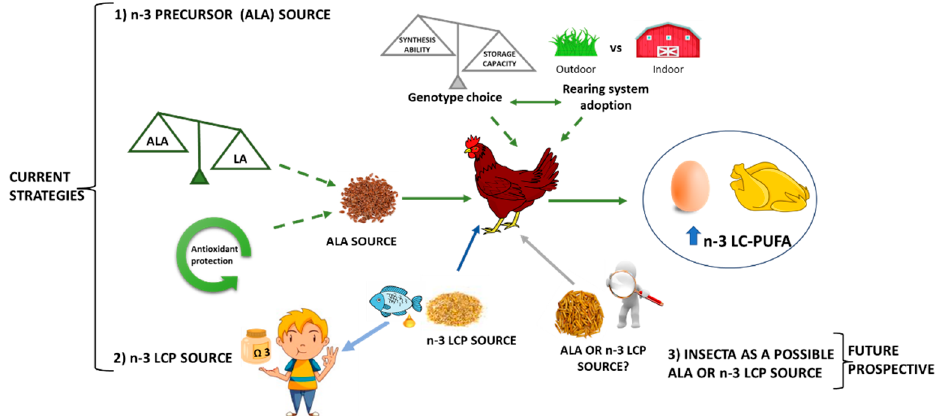
Figure 4. Graphical representation of the main dietary strategies to increase n-3 LC-PUFA in poultry products (egg and meat). The current dietary strategies consist of: 1) providing to animals n-3 precursor (ALA source) or 2) enriching animal feed with n-3 LC-PUFA. 3) A future perspective could be represented by insects as a source of n-3 precursors or n-3 LC-PUFA.